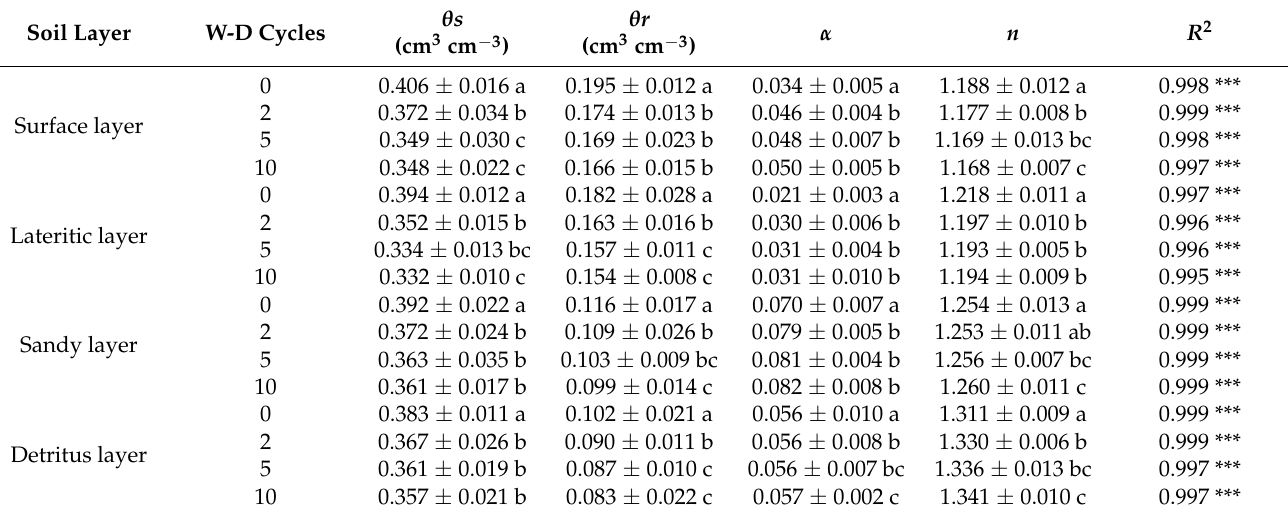
Table 3. The soil water characteristic curve parameters fitted by the van Genuchten (1980) model for experimental soils under W-D cycles